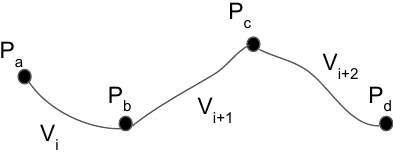
Figure 9. Speed-based